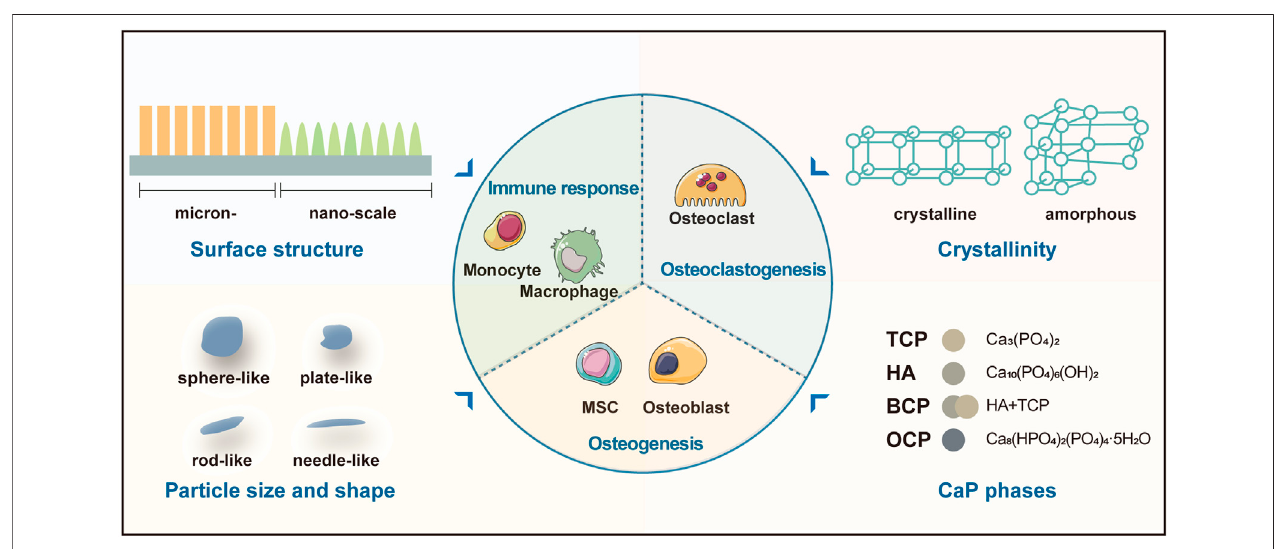
FIGURE 1 | The physico-chemical properties of CaP-based biomaterials affect the activity and function of immune cells, osteoclasts, and osteoblasts. Abbreviation: BCP, biphasic calcium phosphate; TCP, tricalcium phosphate; HA, hydroxyapatite; MSC, mesenchymal stem cell; OCP, octacalcium phosphate.